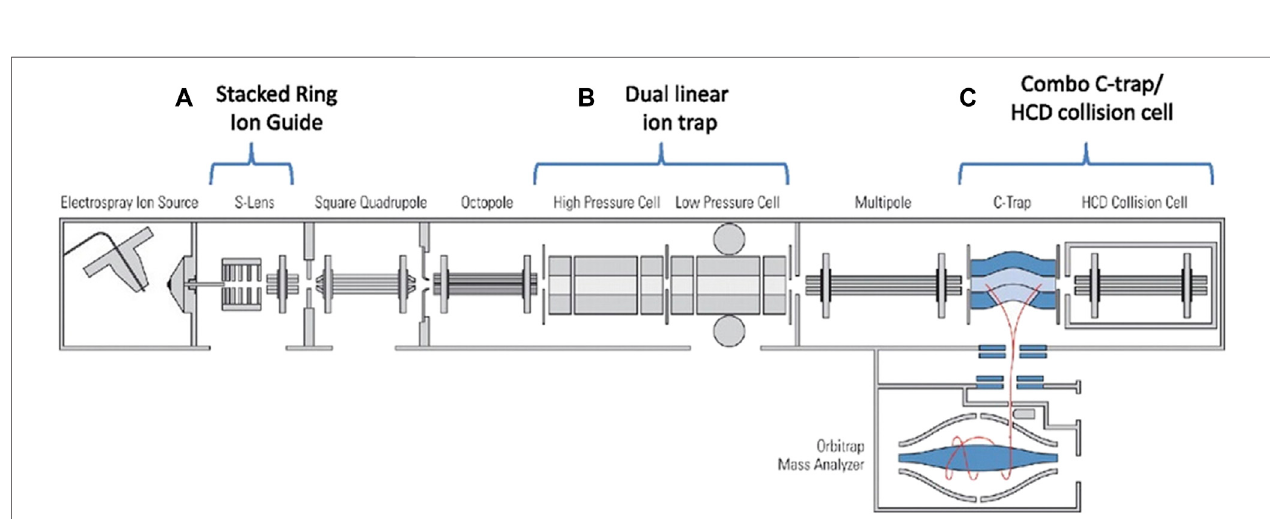
FIGURE 5 | Schematic of the hybrid dual LIT and Orbitrap mass spectrometer. Adapted with permission from Olsen, J. V., Schwartz, J. C., Griep-Raming, J., Nielsen, M. L., Damoc, E., Denisov, E., et al. (2009). Mol. Cell. Proteomics 8, 2,759 – 2,769 (Olsen, et al., 2009). Copyright 2009 Elsevier.